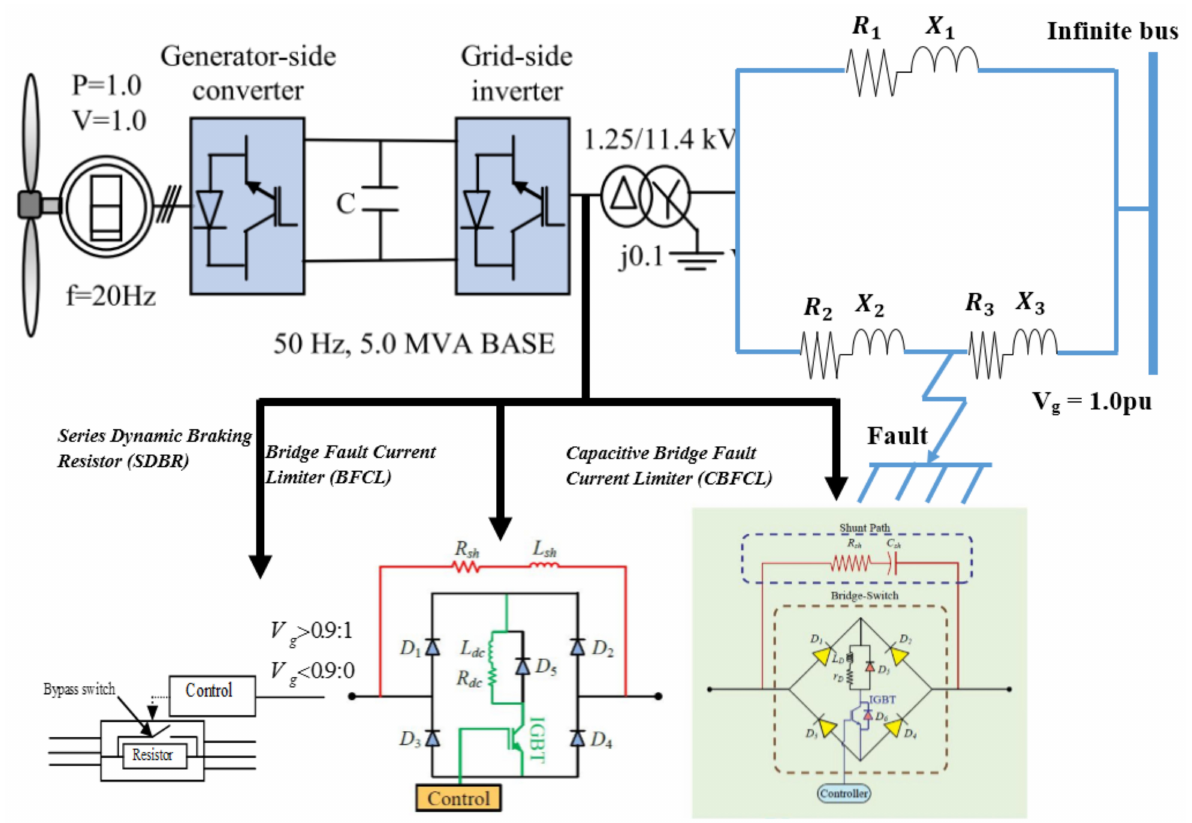
Figure 8. PMSG wind turbine model with the fault current limiters.